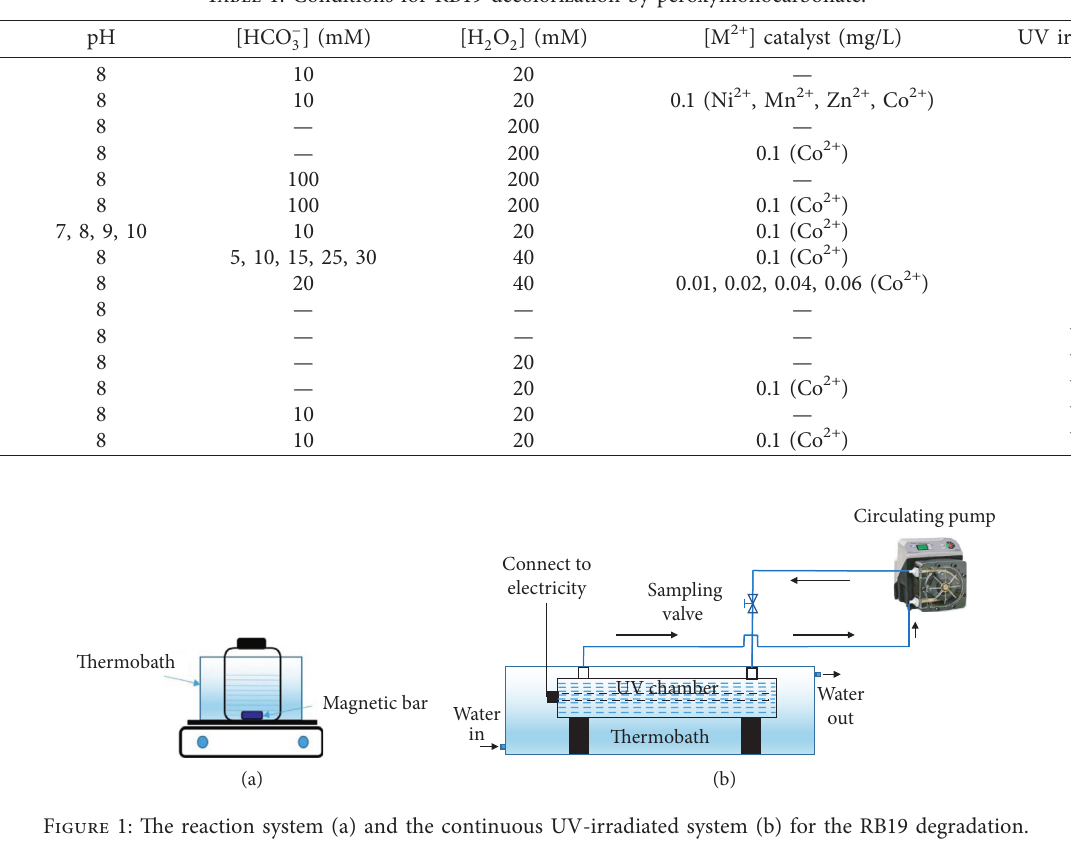
Table 1: Conditions for RB19 decolorization by peroxymonocarbonate.